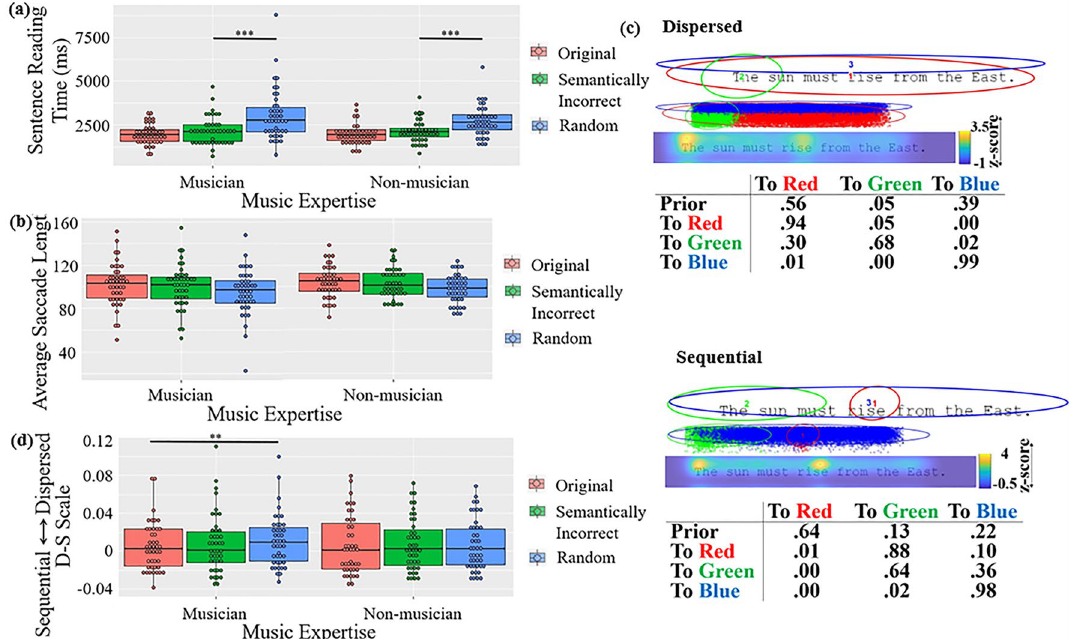
Figure 2. Results for English reading: ( a ) Reading time. ( b ) Average saccade length. ( c ) Two representative eye movement patterns discovered using EMHMM. Ellipses show ROIs as 2-D Gaussian emissions; the border of the ellipses show two standard deviations from the mean. The table shows transition probabilities among the ROIs. Priors show the probabilities that a fixation sequence starts from the ellipse. The smaller images show the assignment of actual fixations to different ROIs and the corresponding heatmap. The assignment of fixations to the ROIs was based on the ROI sequence with the largest posterior probability given the fixation sequence. ( d ) Eye movement pattern measured in D-S scale (*** p < .001, ** p < .01, * p <